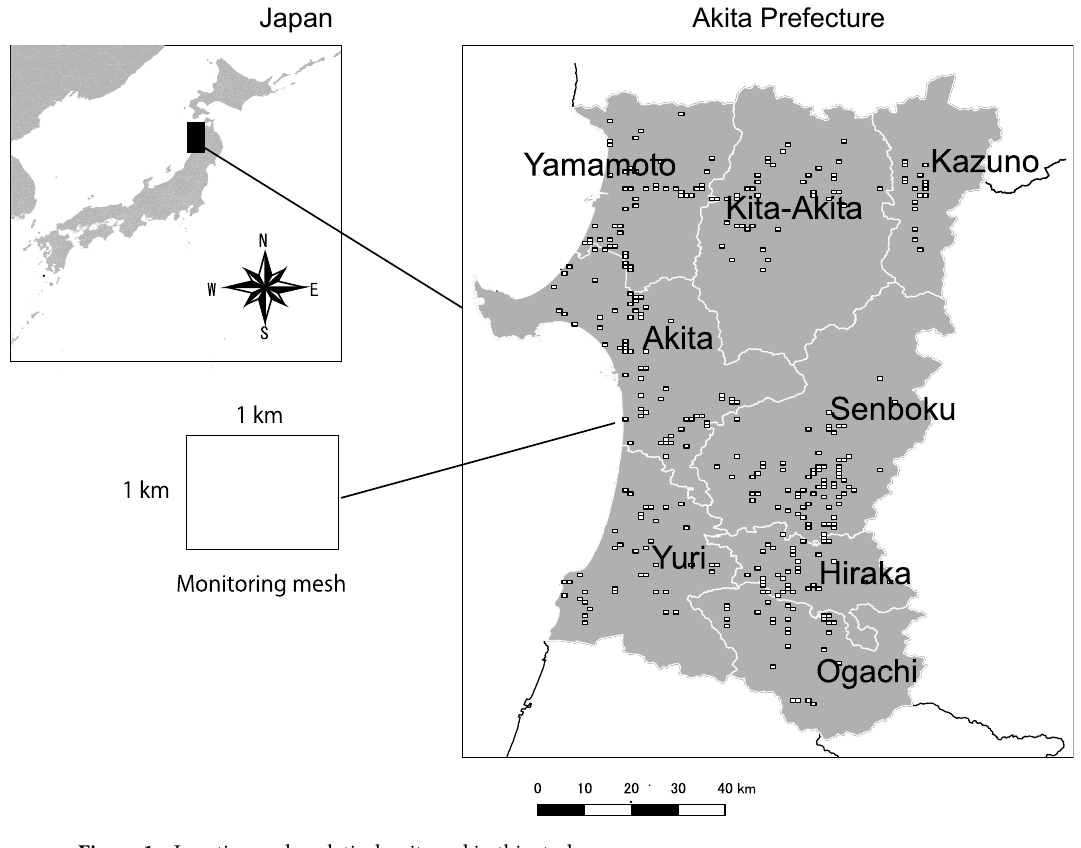
Figure 1. Location and analytical unit used in this